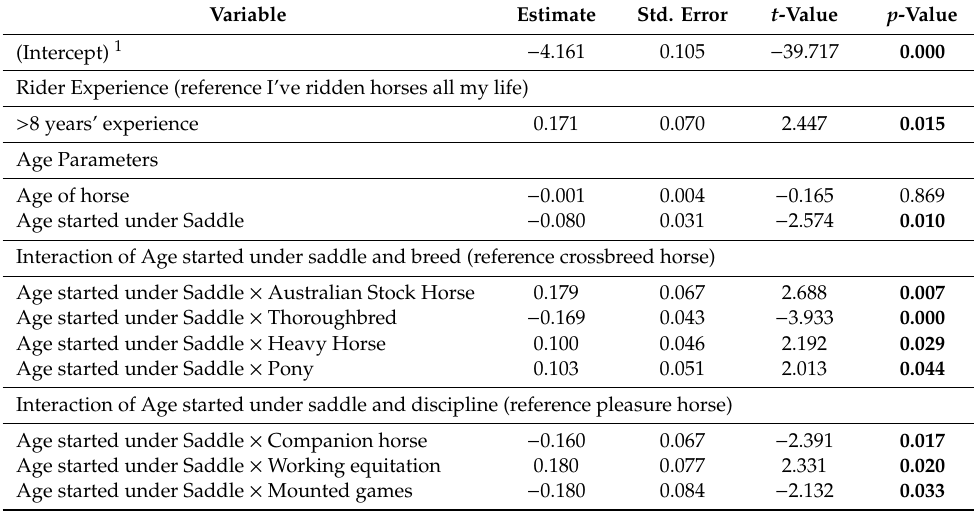
Table 5. Significant age-related variables (in bold) for the suite of traits labelled Independence for horses ( n = 1940) reported by respondents in the